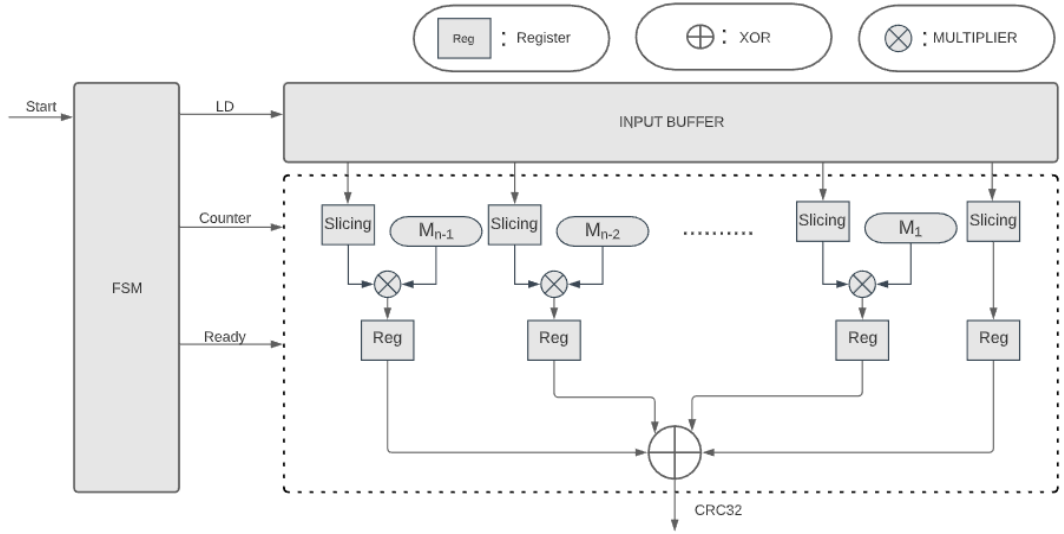
Figure 6. Overall architecture of the parallel CRC computational system. For clarity, not all connections are shown. The counter signal and the ready signal are distributed to all slicing unit and register unit correspondingly.